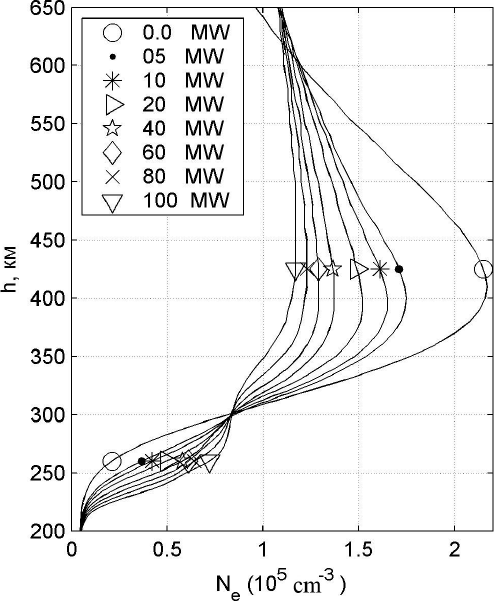
Fig. 1. Profiles of the electron temperature (in units of 10 4 K) ver- sus distance from the Earth along the geomagnetic field line sit- uated in the illuminated region at the moment of 300s after turn on. The results are given for the incident wave frequency value of 3.0MHz and different values of the EAP: 5, 10, 20, 40, 60, 80, and 100MW, with symbol 0MW indicating the results obtained under natural conditions without heating.